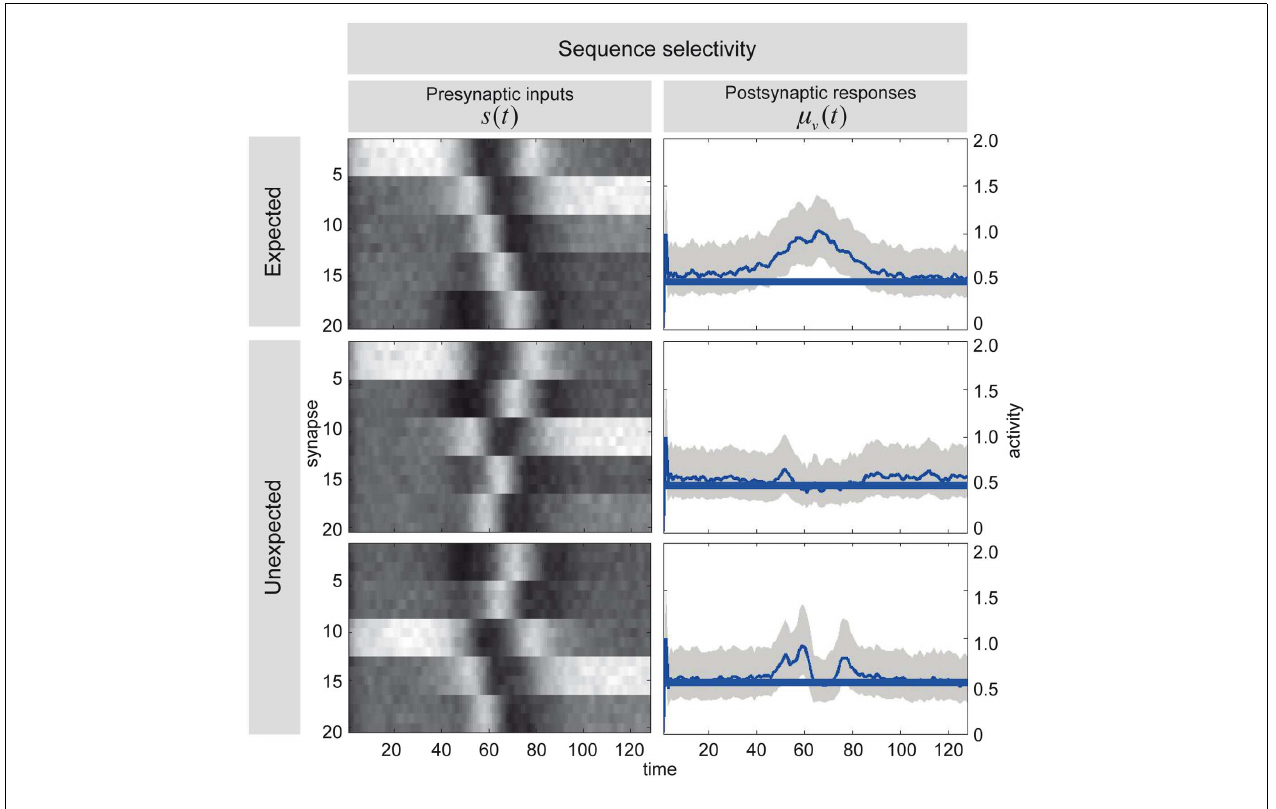
depolarization waves.The post-response is modeled as the time-varying propagation rate exp( μ ( v ) ) (see Eq. 1).Top: For the inward sequence, the branch infers a rate of 1 during the presence of the sequence.The random sequences let the branch infer a rate of the default of 0.5 (no inward sequence present) 1 with brief excursions beyond the value of 0.5 when parts of the sequence were sampled (e.g., lower right plot around time points 40 to 60 and